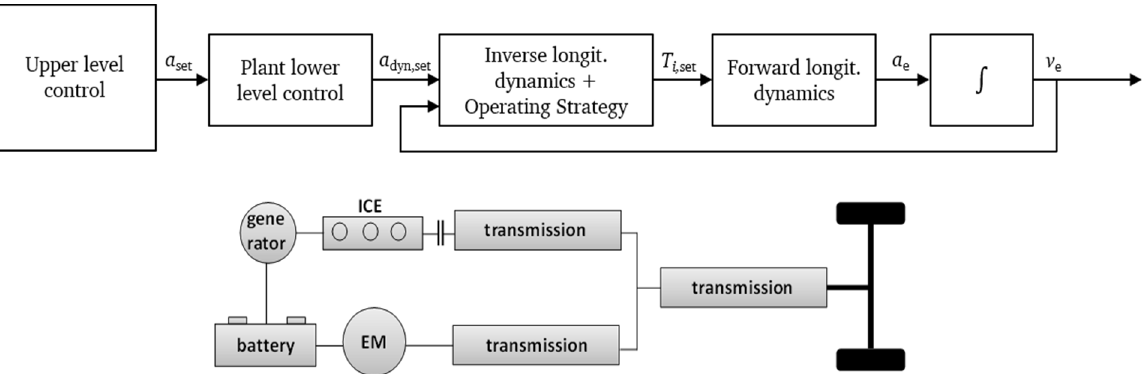
Figure 5. Overview of the control architecture and the vehicle model which is based on the generic powertrain model shown on the bottom and the simplified lower level control.